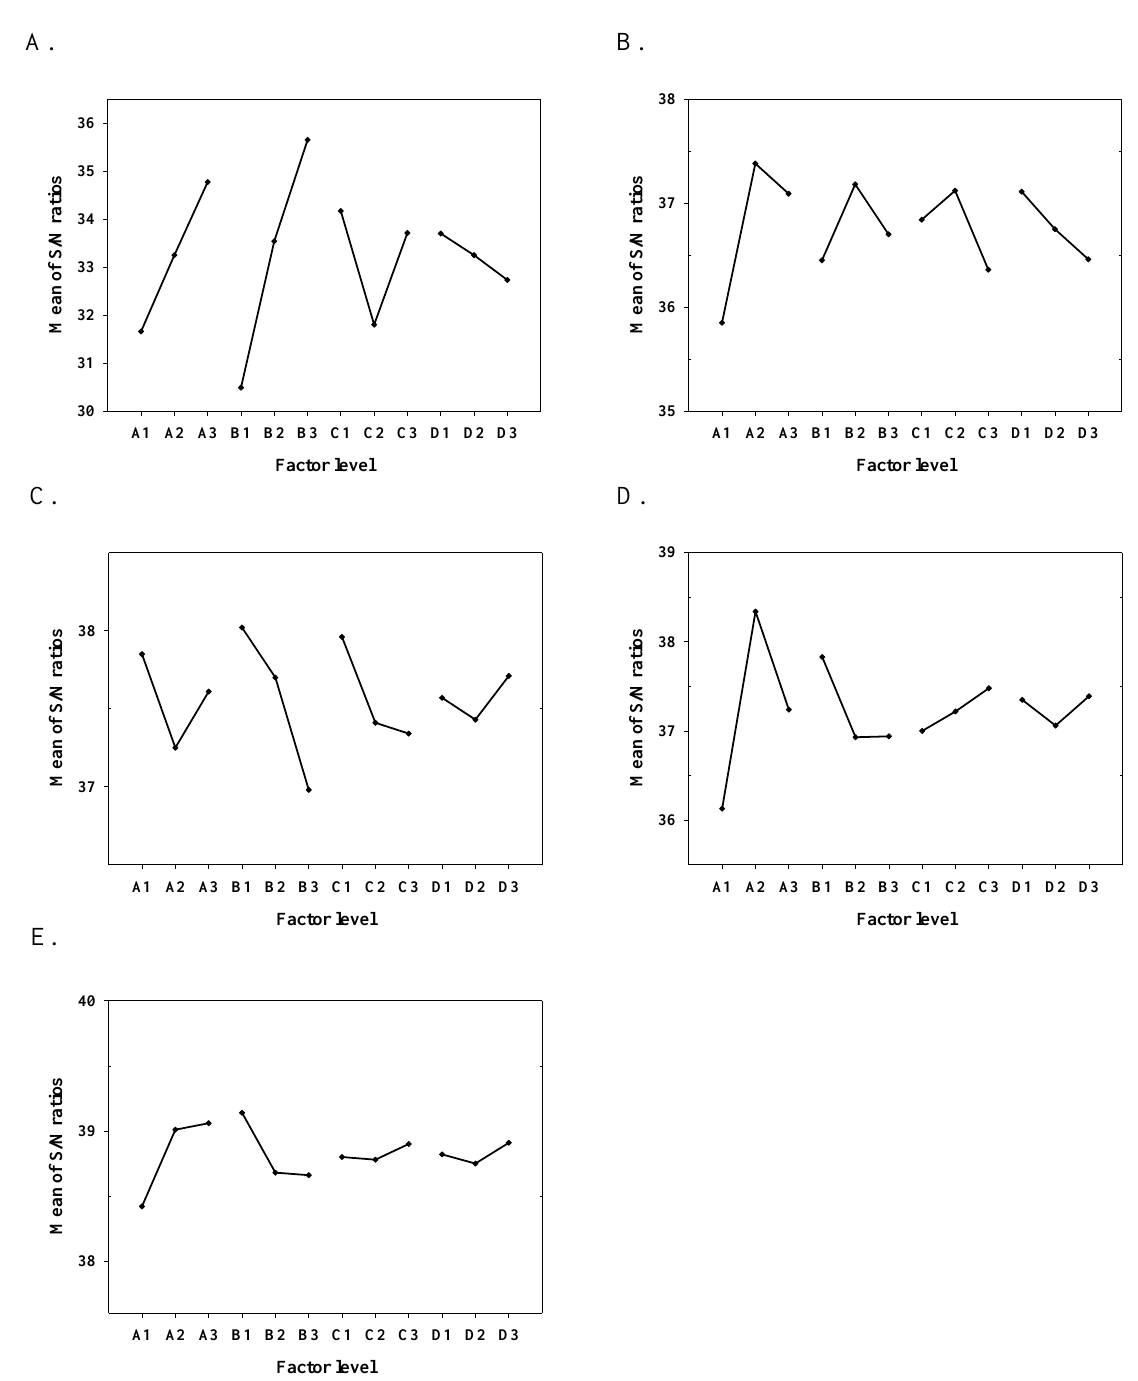
Figure 1. The main plot effects for the signal-to-noise (S/N) ratios of ( A ) the CPSP preparation, the first solvent crystallization by ( B ) ethanol, ( C ) methanol, ( D ) acetone and ( E ) the secondary solvent crystallization by ethanol.